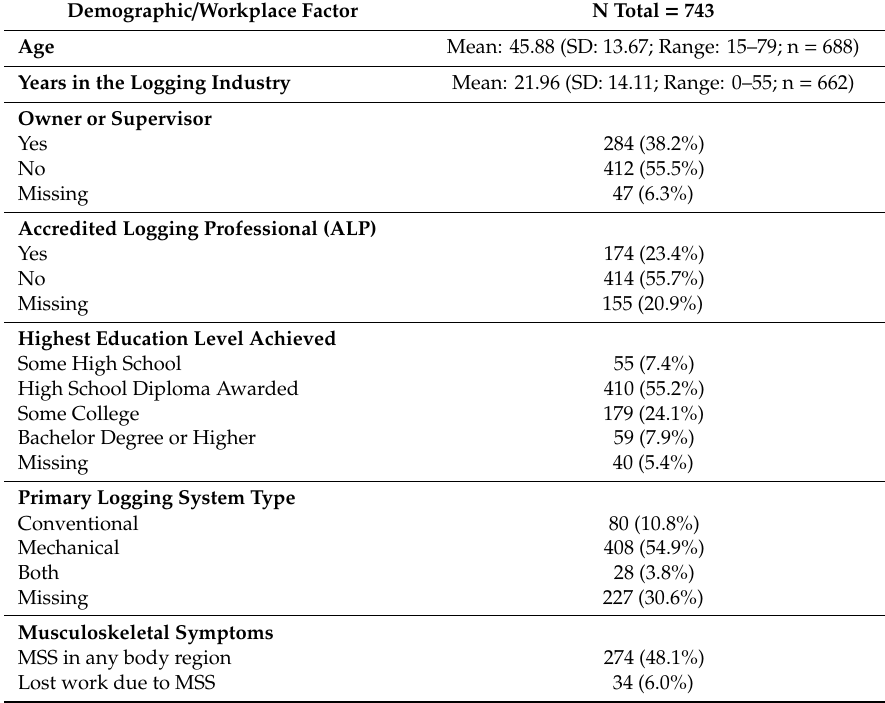
Table 1. Montana logging survey 2017: Respondent